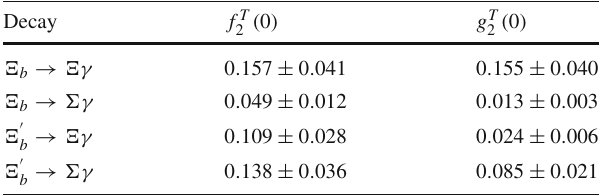
Table 3 The values of corresponding FFs at q 2 = 0 [57]